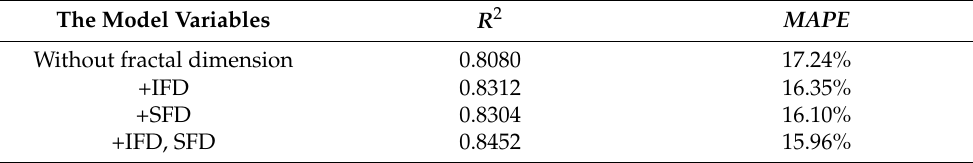
Table 6. R 2 and MAPE for the fresh weight model.